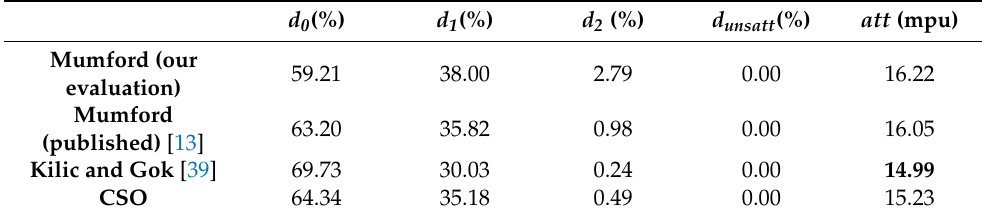
Table 13. Comparative results for the best solutions for Mumford0 network.